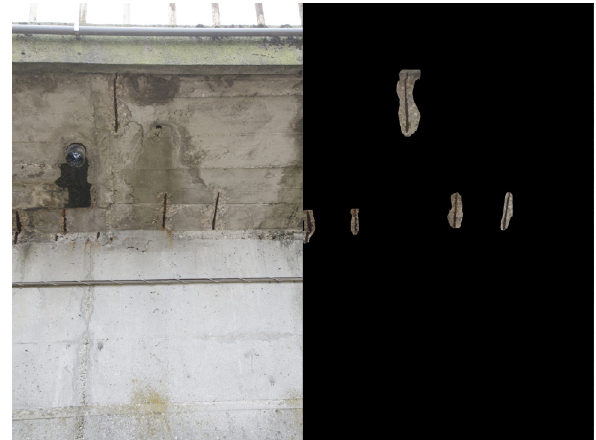
Figure 6. Detailed image of the slab intrados, at right recognized damages